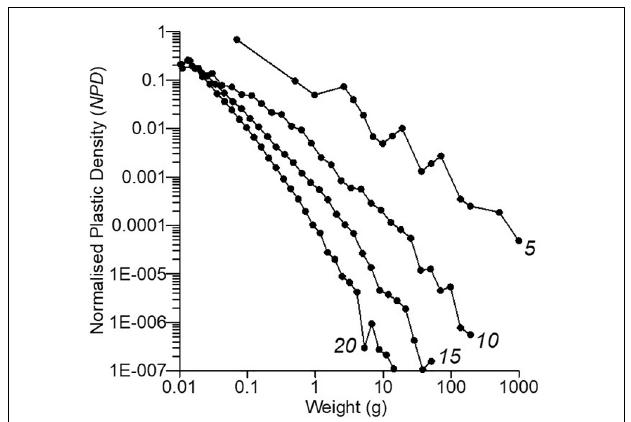
FIGURE 7 | How a 3,000 g particle is split by the fragmentation model. Numbers in italics indicate the number of iterations of the model. x -axis: weights are the centroids of size and weight intervals. y -axis: non-dimensional Normalized Plastic Density ( NPD ) in each weight interval (see section “Methods” for full description). Thirty size and weight intervals (i.e., n = 30) were used for each data set, with the boundaries of each interval calculated as described in the “Methods” section. All particles with weights < 0.01 g were excluded from the analysis. The slopes of the log-log plots for 5, 10, 15, and 20 model iterations are –0.99, –1.29, –1.72, and –2.10,